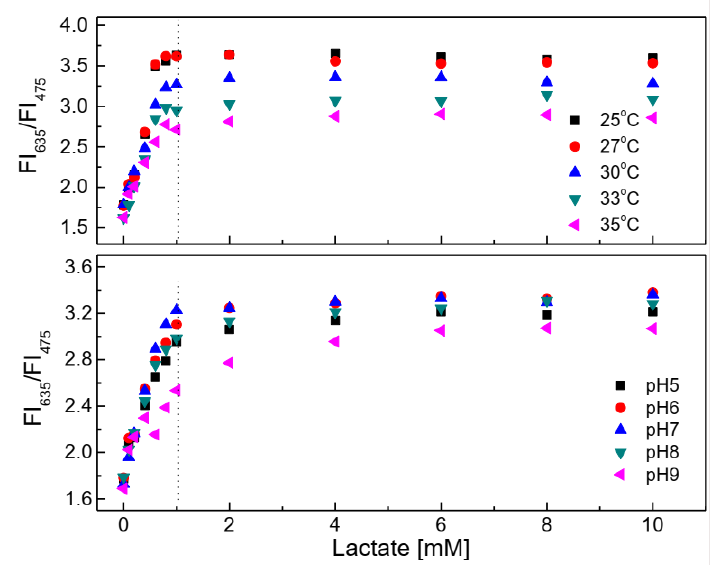
Figure 10. Response of the lactate-sensing membrane at different lactate concentrations in the temperature range of 25–35 ◦ C and pH range of 5.0–9.0.